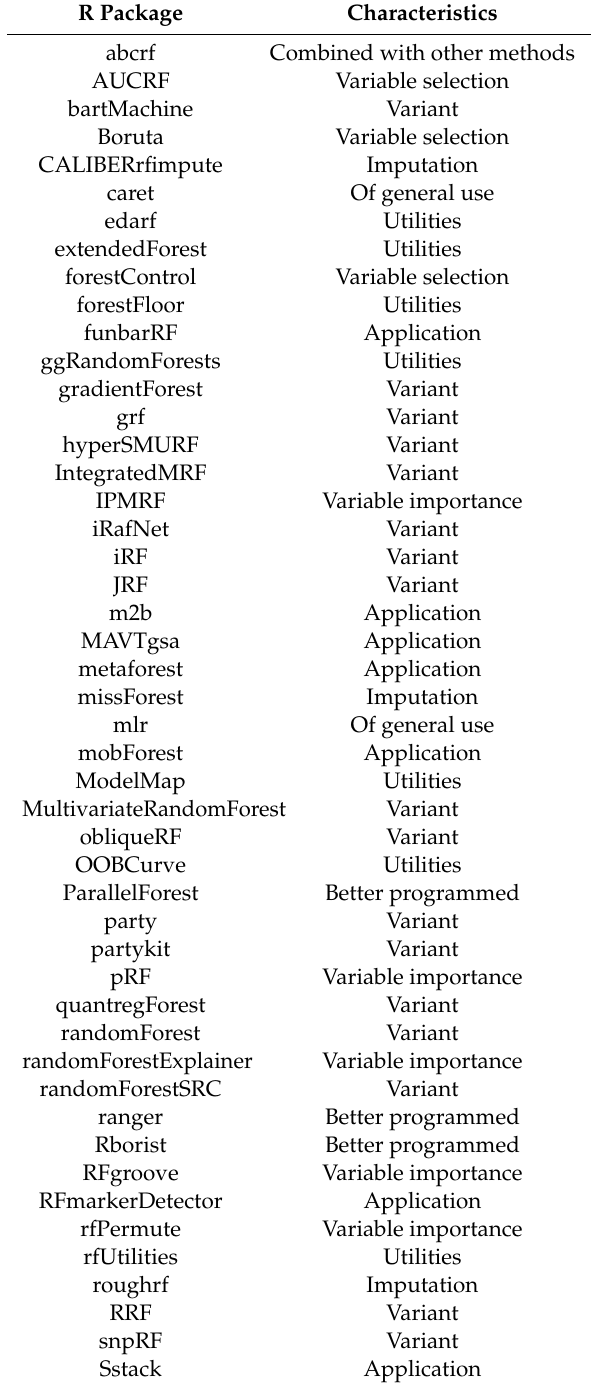
Table 3. R packages related to random forests (in alphabetical order), and their specific tasks. The packages can be found in the Comprehensive R Archive